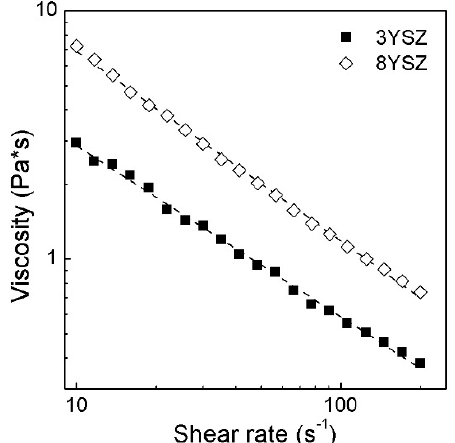
Figure 3. Viscosity of HDDA suspensions as a function of shear rate with two types of zirconia fillers ( φ = 28 vol.%; surfactant BYK w969) at 20 °C.